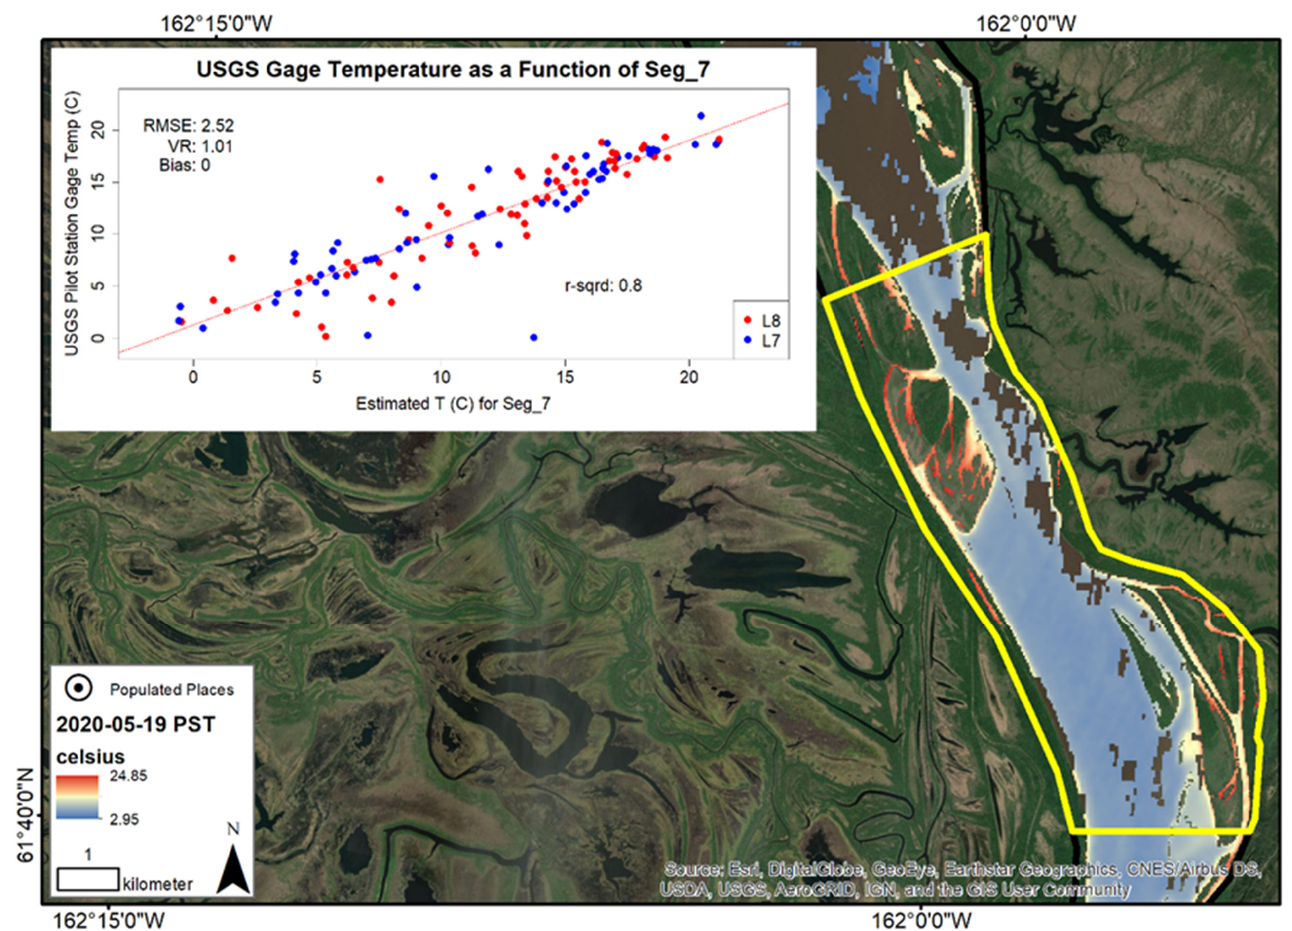
Figure A5. Segment 7 is slightly divided into small sloughs at both the beginning and end of the river segment. The sloughs appear as warmer surface temperatures due to shallow water depths. The eastern shore of the river is rolling uplands of the Ilivit Mountains divided by creeks and branching backwaters that contribute to the Yukon River. These water sources do not appear to influence the overall temperature of the river, as correlation with measured water temperature is good (RMSE = 2.52 °C, r 2 = 0.80) and similar to that of upstream river segments. Wetlands that comprised abandoned channels, oxbows, and broad lakes lie to the west.